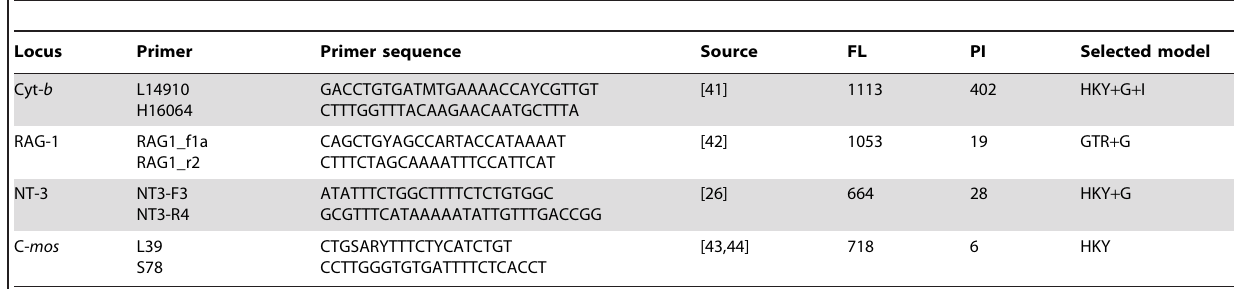
Table 5. Primer sequences, sources, aligned fragment length (FL), number of parsimony informative sites (PI) and models of sequence evolution selected for the four loci used in this